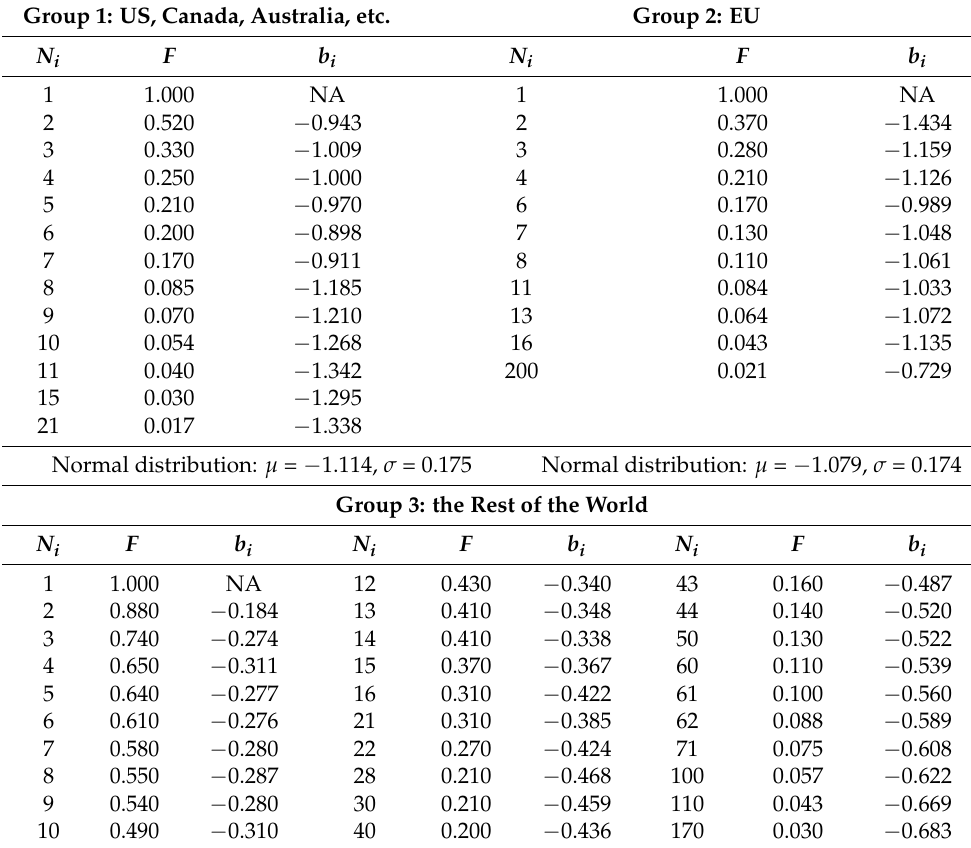
Table 3. Accumulated frequency of land transport accidents with N deaths for the three groups digitized from Oggero et al.